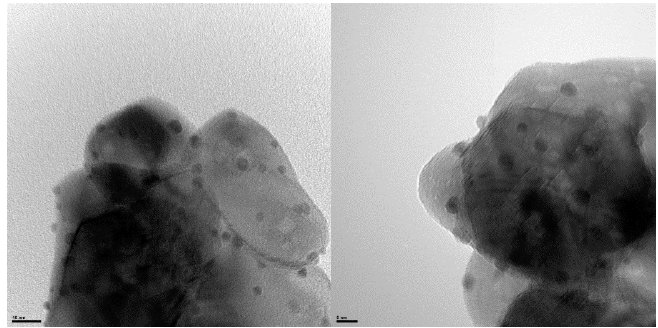
Figure 4. HR-TEM images of Au/CeO 2 photocatalysts obtained from M. Omri et al. [43].